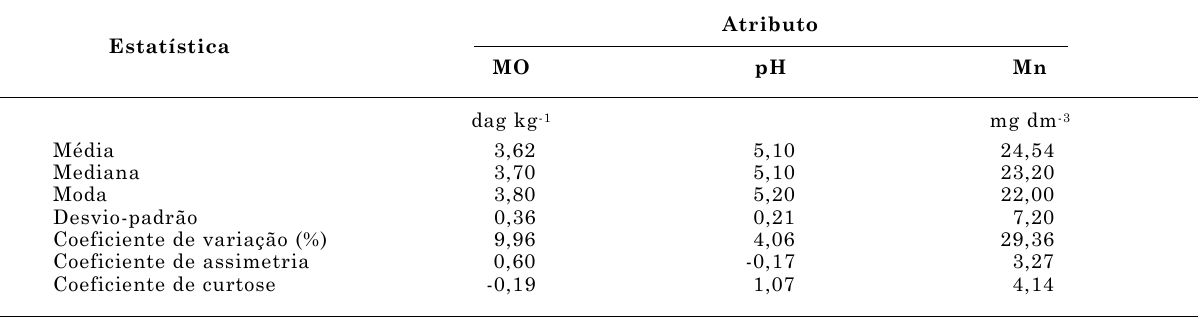
orgânica, de pH e do teor de manganês.